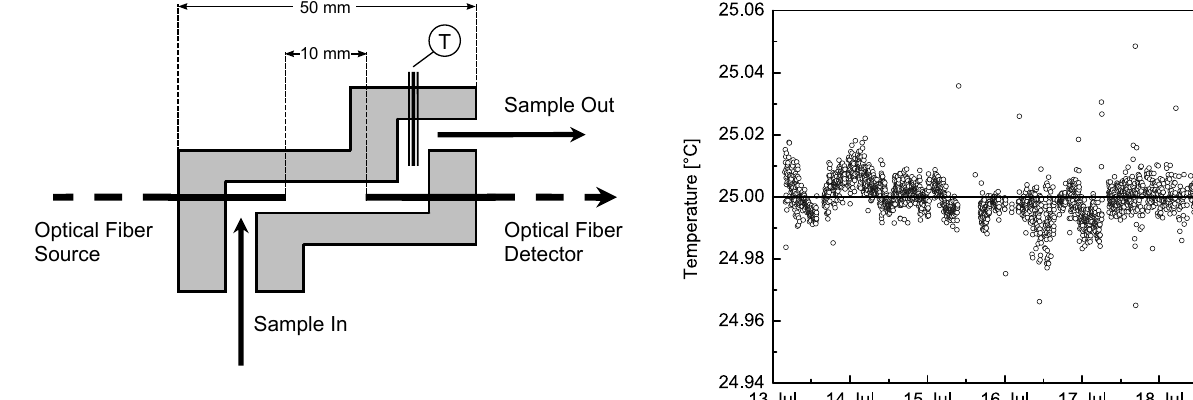
Fig. 2. Design of the custom made cuvette. The length of the optical path between the two fiber probes is 10mm. Each fiber has an over- lap into the cuvette of 5mm to minimize perturbations caused by air bubbles. T is a temperature sensor for direct sample measurements and temperature regulation of the sample.